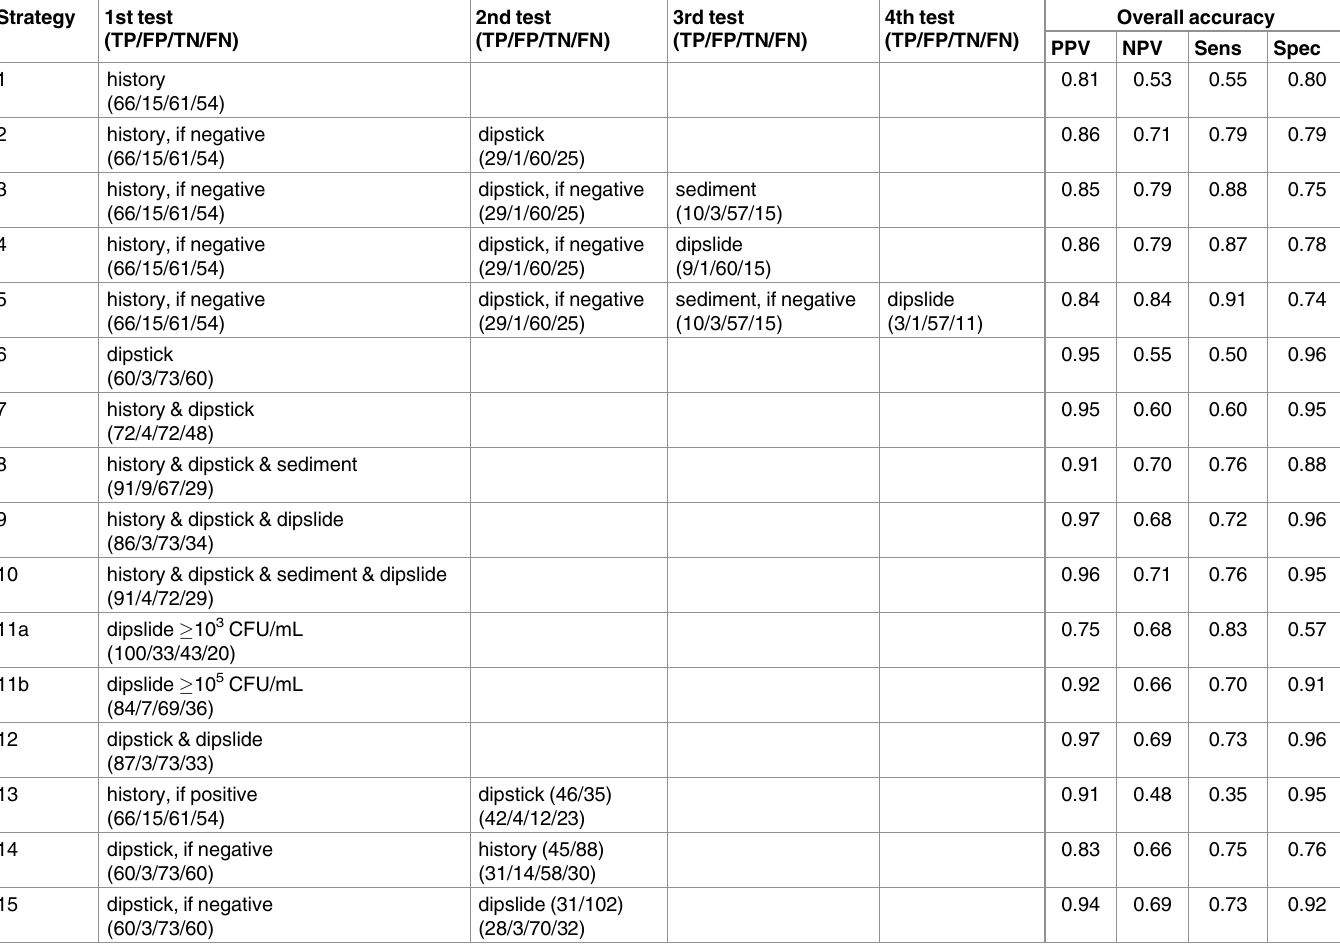
Table 1. Diagnostic strategies evaluated in the decision trees derived from empirical data on 196 women contacting their GP with painful and/or frequent micturition.